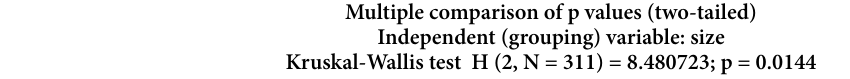
Table 7. Multiple comparison method by categories Multiple comparison of p values (two-tailed) Independent (grouping) variable: size